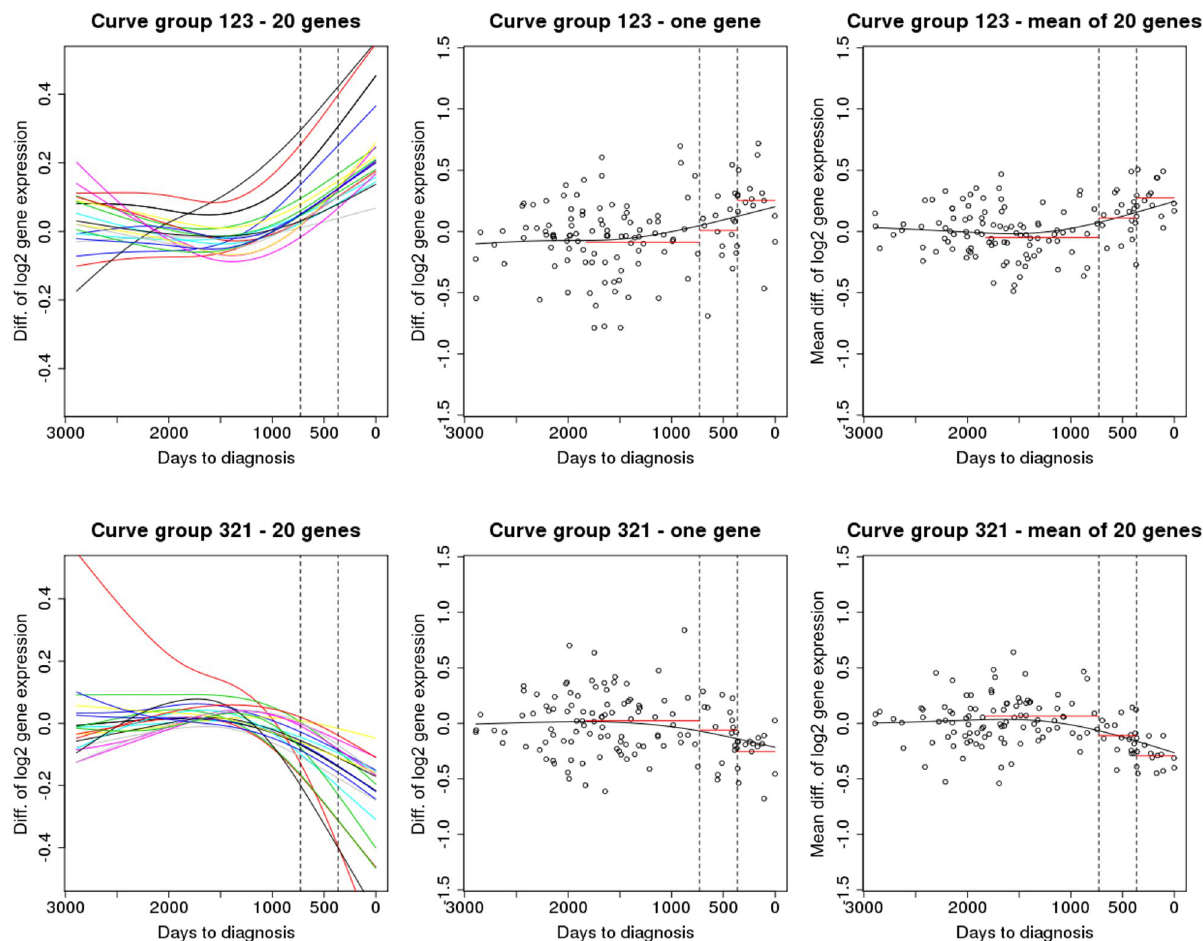
Figure 1. Curve group ‘123’ (upper panels; differences in gene expression values for cases and matched controls highest closest to diagnosis) and ‘321’ (lower panels; gene expression differences highest further from diagnosis) according to time to diagnosis. The left panels present spline-estimated curves for 20 randomly selected genes from each given curve group for illustrational purposes. The dashed, vertical lines indicate the last 2 years prior to diagnosis. In the middle panel the circles represent the differences in gene expression for each case–control pair for one randomly chosen gene, and the respective mean values in each time period are displayed in red and a spline-estimated curve with the gene expression differences for the same gene is displayed in black. The right panels display the same results as the middle panel but calculated for 20 genes.